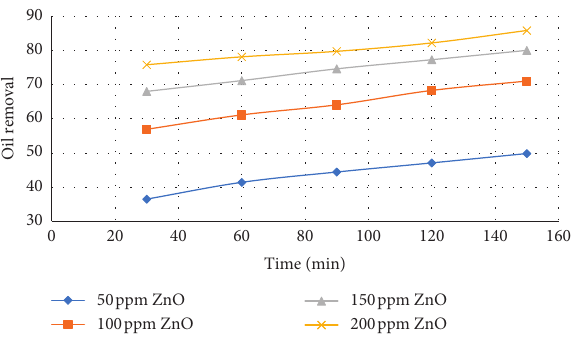
Figure 6: Irradiation time effect on removal of PW by adding 150 ppm ZnO at pH �